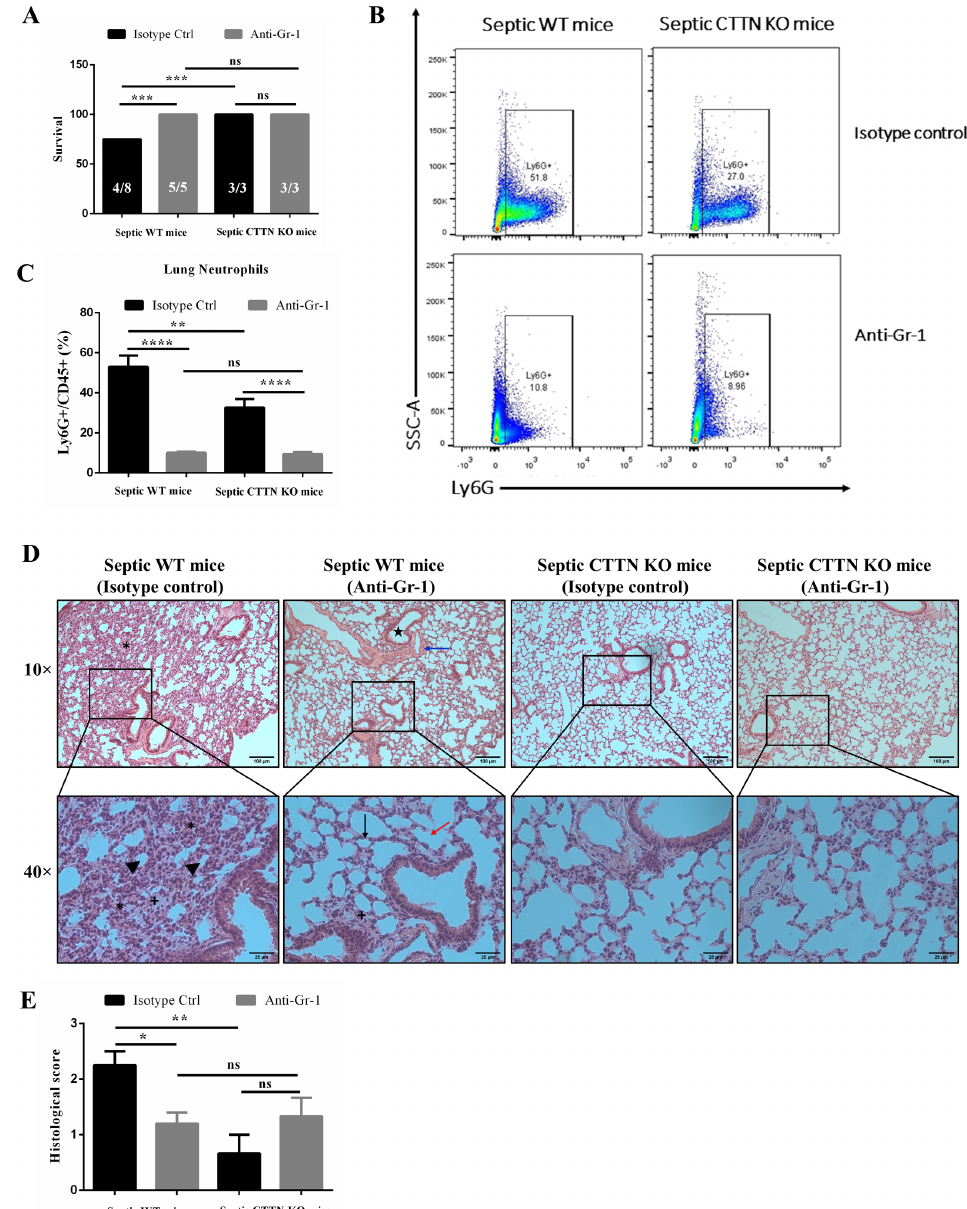
Figure 8. Neutrophil depletion had no additional effect on septic cortactin-deficient mice. ( A ) Survival analysis 24 h after CLP surgery and 12 h after injection of the respective antibodies. ( B ) Representative flow cytometry plots showing similar neutrophil levels in the lungs when injected with either anti-mouse Gr-1 antibody or isotype control antibody 12 h after CLP sepsis. Flow cytometry of lung tissue suspensions was done 24 h after the onset of sepsis (12 h after injection of the antibodies). ( C ) Frequency of CD45+ Ly6G+ neutrophils in the lungs of septic mice 24 h after CLP surgery. ( D ) Representative haematoxylin–eosin-stained images of septic WT mice and septic CTTN KO mice injected with either anti-mouse Gr-1 antibody or isotype control antibody. Septic WT mice that